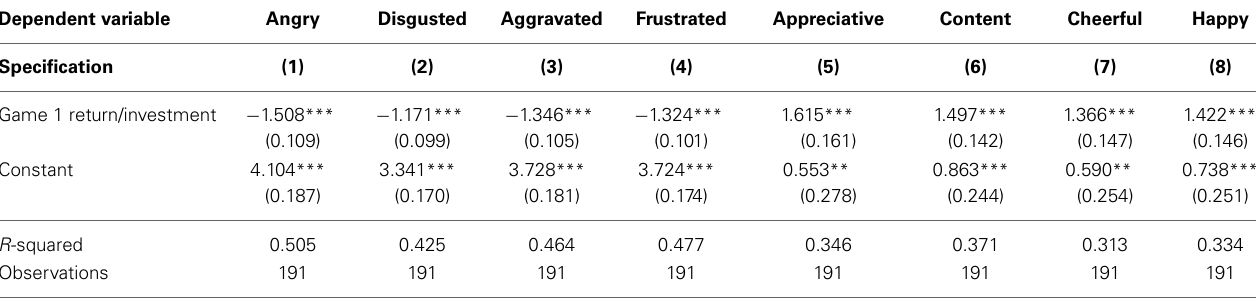
Table 4 | Regression of investors’ emotions on ROI .